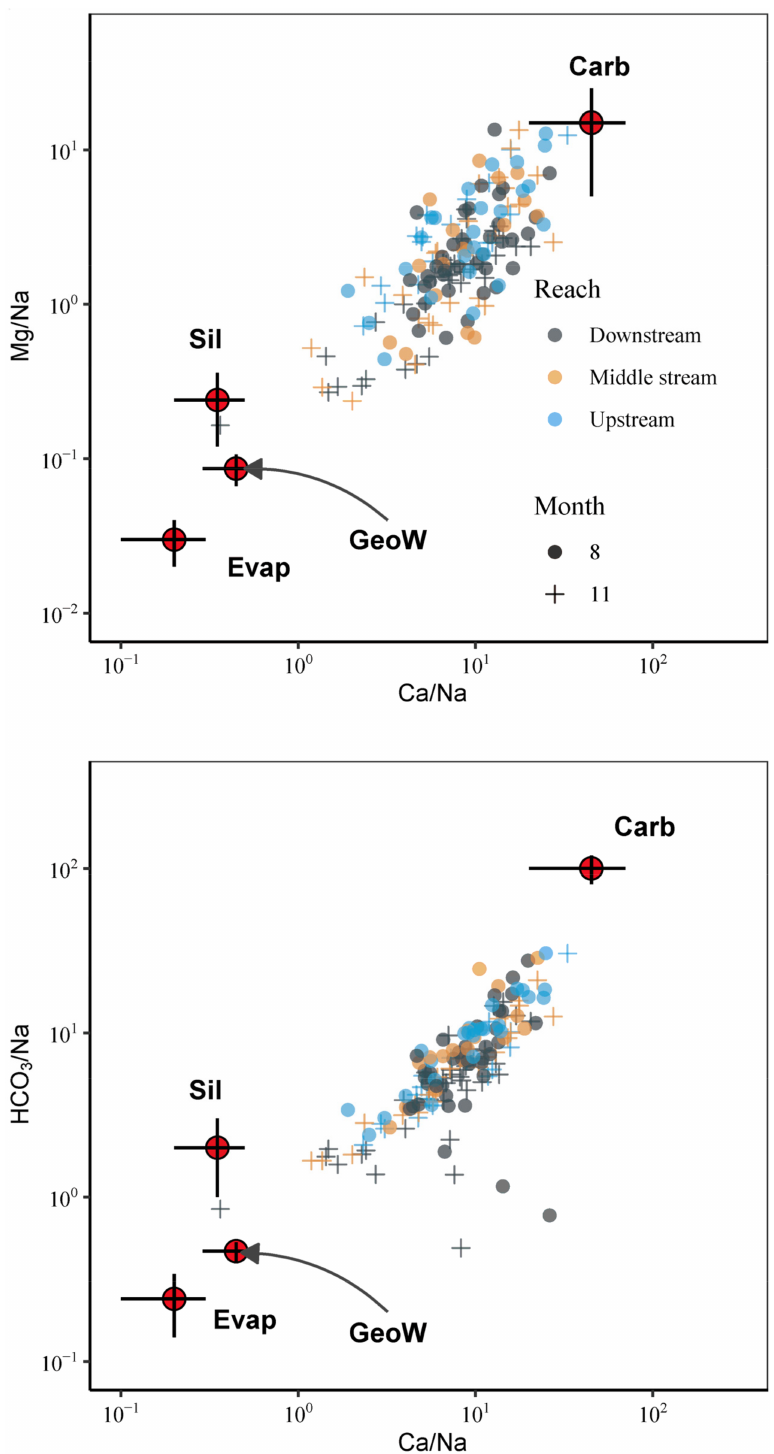
Figure 5. Mixing plot of Na-normalized ions molar ratios of the LR during rainy and dry seasons. End-members of evaporates (Evap), silicates (Sil), and carbonates (Carb) are attained from Gaillardet et al. [51]. End-member of geothermal water (GeoW) was obtained from Guo et al.